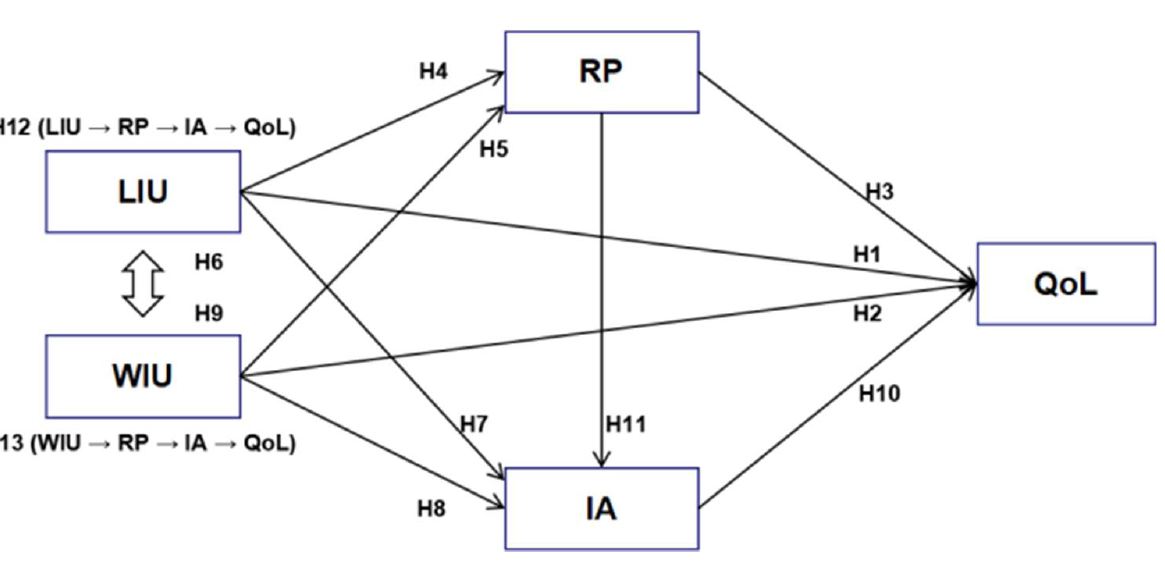
Table 1. Results of mean, SD, and ANOVA ( n = 1535). Socio-Demographics